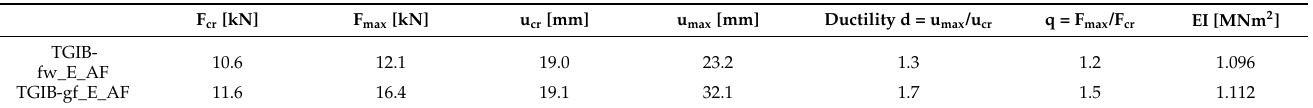
Table 11. Comparison of results of measurements for TGIB-fw and TGIB-gw with annealed float glass with epoxy